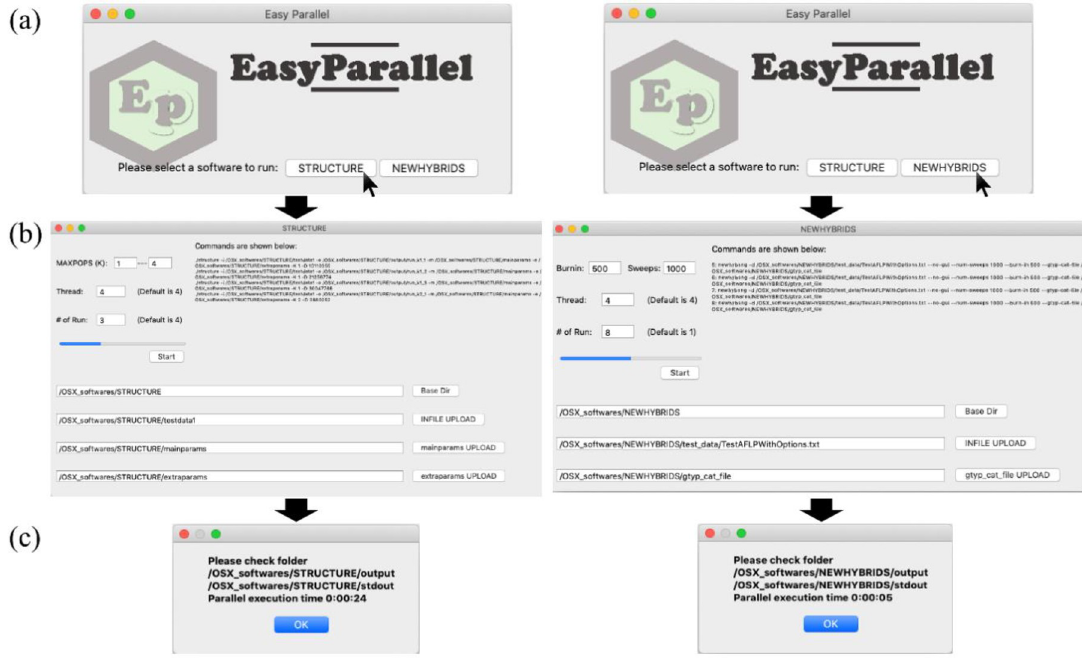
Fig 1. A screenshot of EasyParallel running the STRUCTURE and NEWHYBRIDS analyses in parallel. (a) EasyParallel main window allows user to choose the STRUCTURE or NEWHYBRIDS module for data analysis. (b) The module panel assisting the user in adding major parameters (e.g. the number of thread or runs) and the input/parameter files. A progress bar at left shows the status of parallelization. A command window at top right shows the commands used for data running. (c) Message window shows the folder storing the outputs and the time to complete the